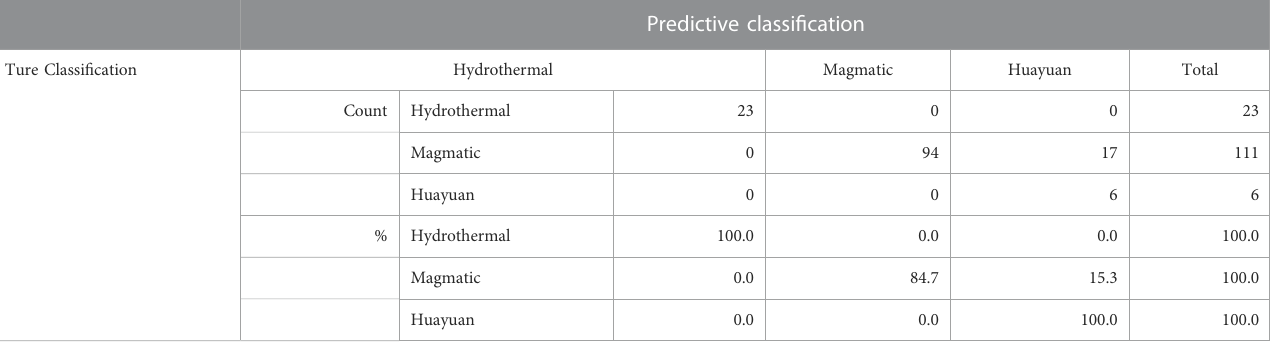
TABLE 2 Fisher discriminant predictive classi fi cation, based on trace element concentrations.